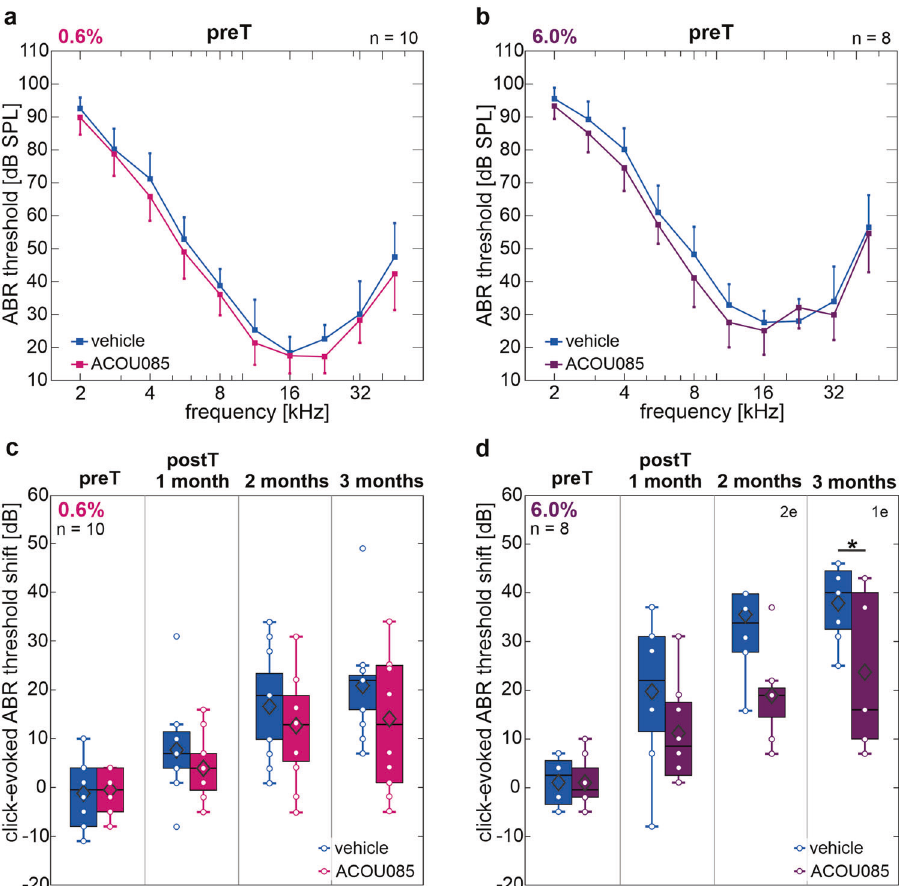
Fig. 3 ABR thresholds of SAMP8 mice before treatment and click-evoked ABR threshold shifts of SAMP8 mice treated with ACOU085 and vehicle control. a , b Mean and standard deviation of ABR thresholds are shown for SAMP8 mice at the age of 45 days before treatment with ACOU085 at 0.6% ( a ) or 6.0% ( b ) w/v dose or contralateral vehicle control. c , d Means (diamonds), box plots, and individual (circles) click- evoked auditory brainstem response (ABR) threshold shifts are shown for SAMP8 mice treated unilaterally with either 0.6% ( c ) or 6.0% ( d ) w/v ACOU085 and contralateral vehicle control measured at different timepoints: pre-treatment (preT), and 1-, 2-, 3-months post-treatment (postT). Threshold shifts were calculated as the difference between individual thresholds and the population mean at preT. Signi fi cant pairwise comparisons (paired-samples t- Test) are indicated by asterisks (* p < 0.05). Note that due to technical issues resulting in data loss, two mice had to be excluded at the 2-months and 1 mouse at the 3-months postT intervals, respectively, in the 6.0% group. This is denoted by “ 1e ” and “ 2e ” , i.e., 1 ear and 2 ears excluded,